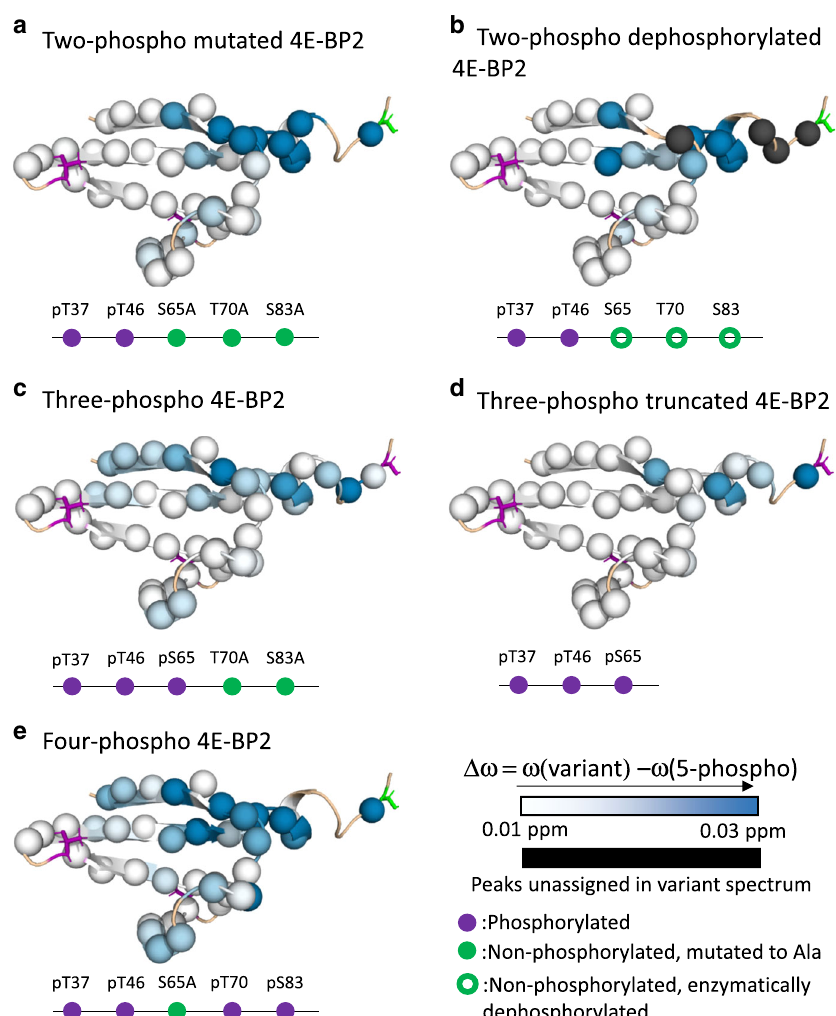
Fig. 3 Effects of the C-IDR and its phosphorylation status on the 4E-BP2 folded domain. Changes in backbone amide chemical shifts, Δ ω (here referenced to 5p-4E-BP2) indicate that the structure and dynamics of 5p-4E-BP2 were perturbed by modi fi cations, either by mutations that preclude full phosphorylation or de-phosphorylation. The Δ ω values are mapped onto residues 18 – 66 of 4E-BP2 structure as a white-to-blue gradient. The analyzed residues are shown as spheres. The positions of the phosphates (purple stick diagrams, purples circles on the schematic) and alanine mutations that cannot be phosphorylated (green stick diagrams, circles on the schematic) are indicated. For further details, see Supplementary Fig. 4. a 2p-4E-BP2 phosphorylated at T37 and T46, with S65A/T70A/S83A mutations. b Wildtype 2p-4E-BP2. 5p- (unmutated) 4E-BP2 was de-phosphorylated to 2p-4E- BP2 using lambda protein phosphatase. Residues with missing peaks in the four-hour de-phosphorylation 15 N – 1 H HSQC are shown as black spheres (residues 25, 62, 63, and 65). c 3p-4E-BP2 phosphorylated at T37, T46, and S65, with T70A/S83A mutations. d 3p-truncated 4E-BP2 containing residues 1 – 67 of 4E-BP2, phosphorylated at T37, T46, and S65. e 4p-4E-BP2 (full-length) 4E-BP2 phosphorylated at T37, T46, T70, and S83, with a S65A mutation. Source data are provided as a Source Data fi